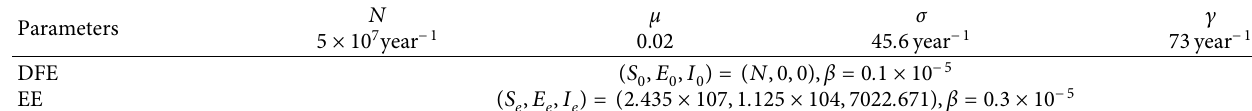
Table 2: Parameters value of the measles model.